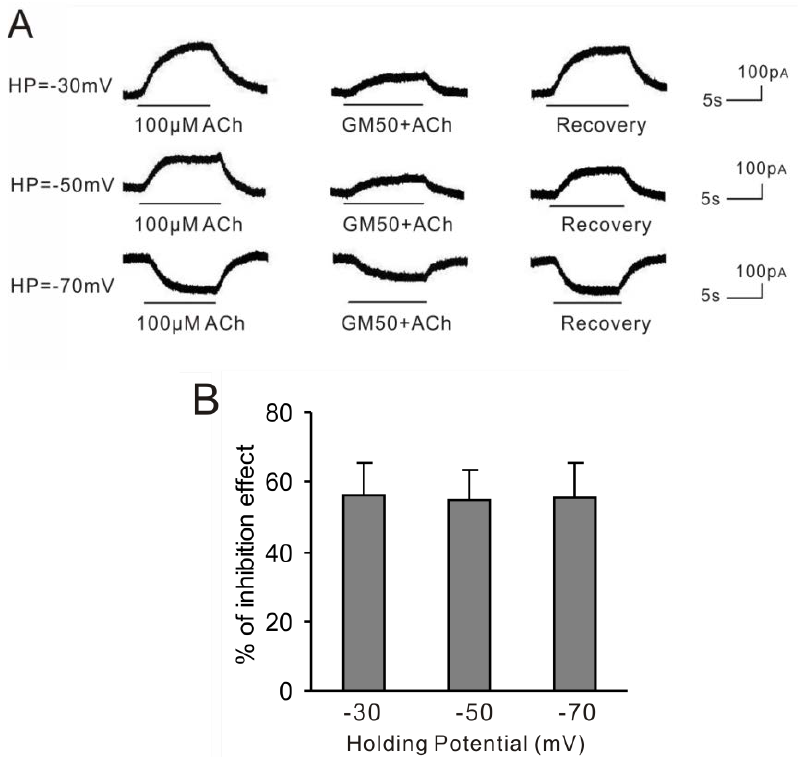
Figure 3. The blocking effects of GM at different holding potential. ( A ) Currents were sequential current traces evoked by 100 µM ACh (ACh100) alone or with 50 µM GM at holding potentials of −30, −50 and −70 mV. Results were obtained from the same cell; ( B ) Bar histogram showing the percentage of the blocking effect of 50 μM GM on 100 μM ACh-induced BK currents at three different holding potentials (−30, −50 and −70 mV). Each point is the mean ± SD of 5